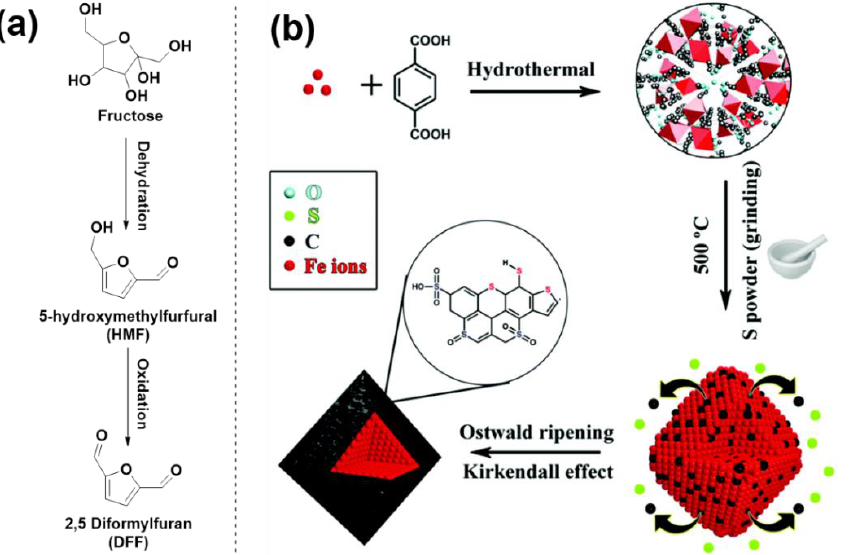
Figure 13. ( a ) One-pot synthesis of DFF from glucose. ( b ) Synthetic strategy for Fe/C-S catalysts (The illustration proposed the possible structure in the catalyst). Reprinted with permission from Ref.